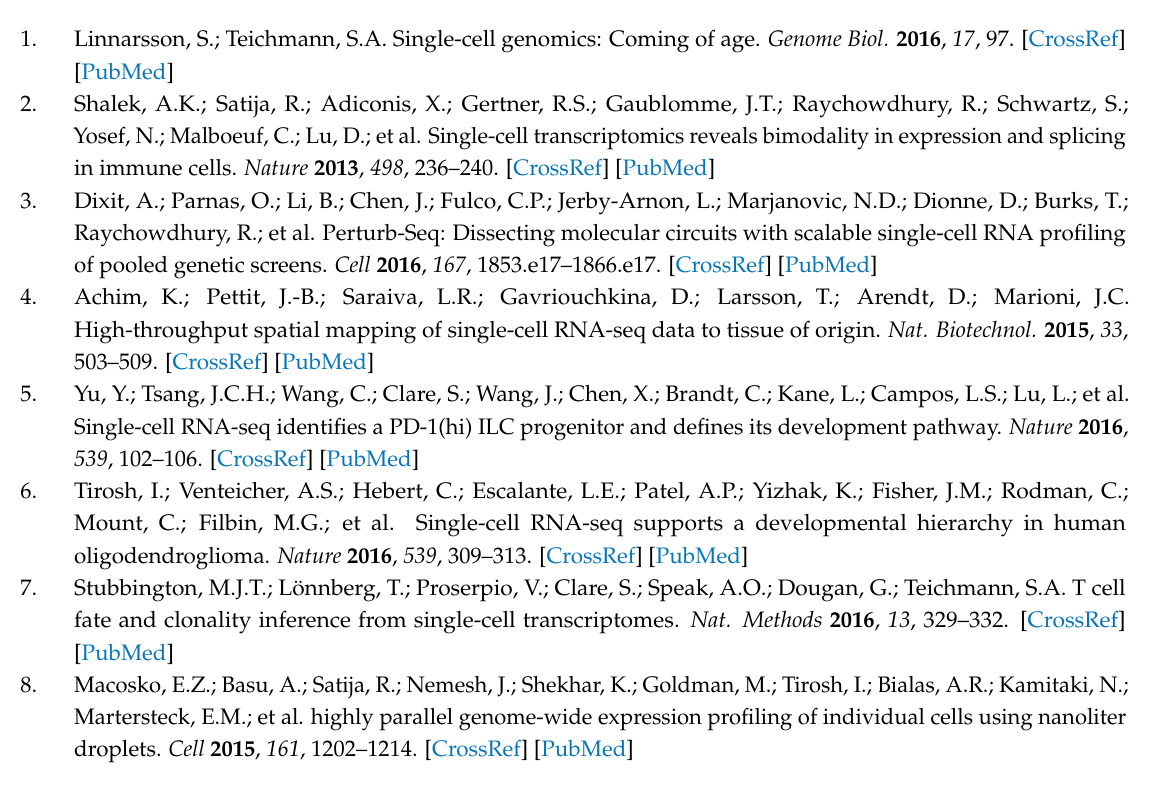
Figure S1: LRG1 gene expression rank across scRNA-Seq datasets. The figure was generated by searching LRG1 from scRNASeqDB and saved in one of the available formats (PDF, PNG, JPG, or SVG). Table S1: Summary of the search results in the PubMed database by different search strategies (by 1 July 2016). Table S2: Summary of datasets in scRNASeqDB. Table S3: Summary of cell lines or types in